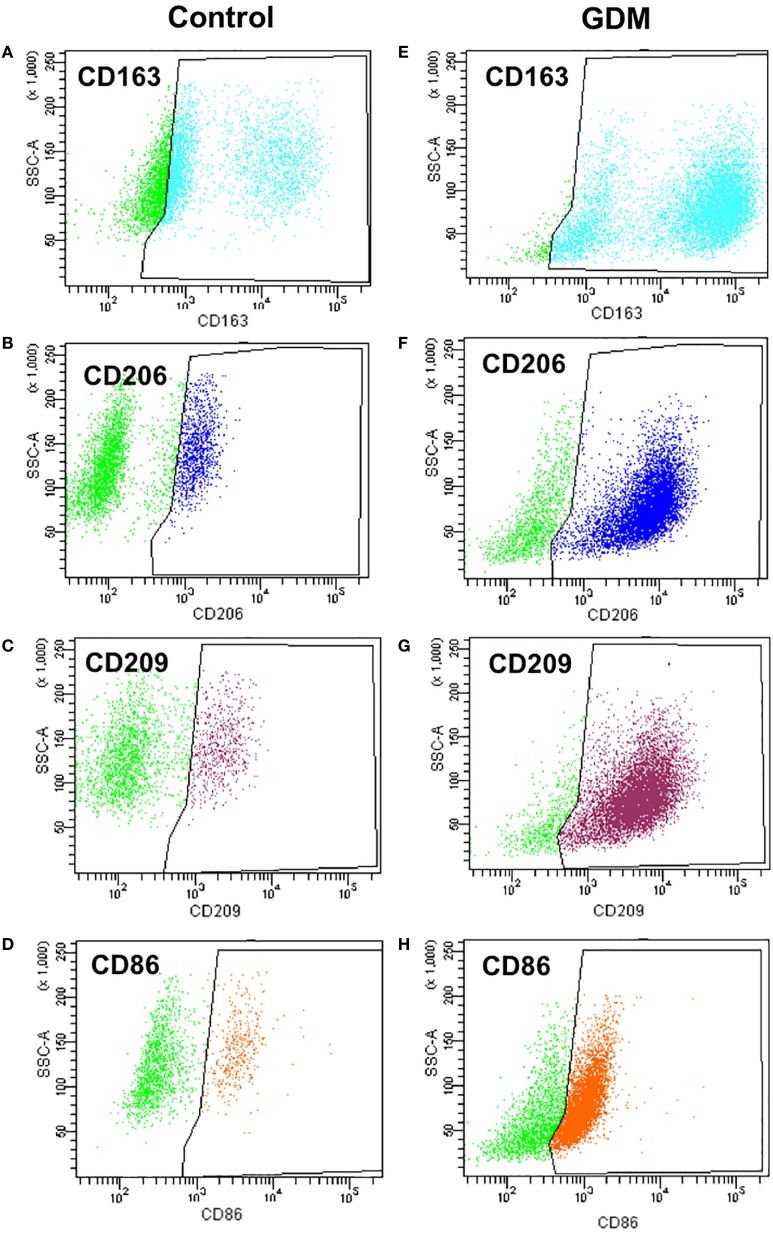
Flow cytometry analysis of M1 and M2 markers in control and gestational diabetes mellitus (GDM)-Hofbauer cell (HBC). (A,E) CD163 positive population size was similar in HBCs isolated from control (A) and GDM (E) placenta. (B,F) HBCs isolated from GDM placenta (F) constitute a larger population positive for the M2 marker CD206 than control HBC (B). (C,G) HBCs isolated from GDM placenta (G) constitute a larger population positive for the M2 marker CD209 than control HBC (C). (D,H) GDM HBCs tended to have a larger population of CD86 positive cells, representing presence of either M2b or M1 macrophages. N = 4 isolations/group were used for FACS analysis, one representative experiment shown.